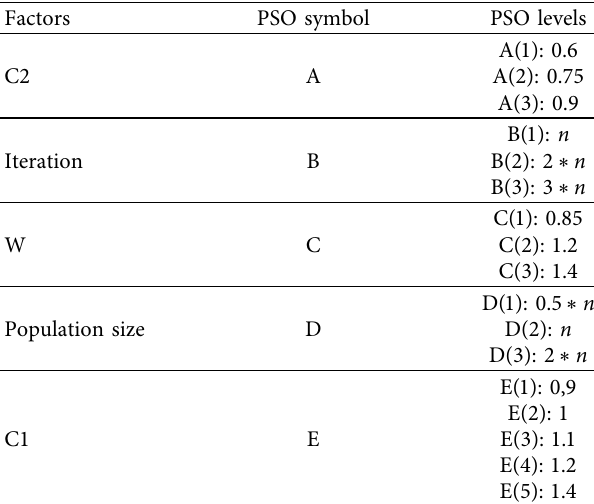
Table 2: Candidate factors and levels in the group particle opti- mization algorithm